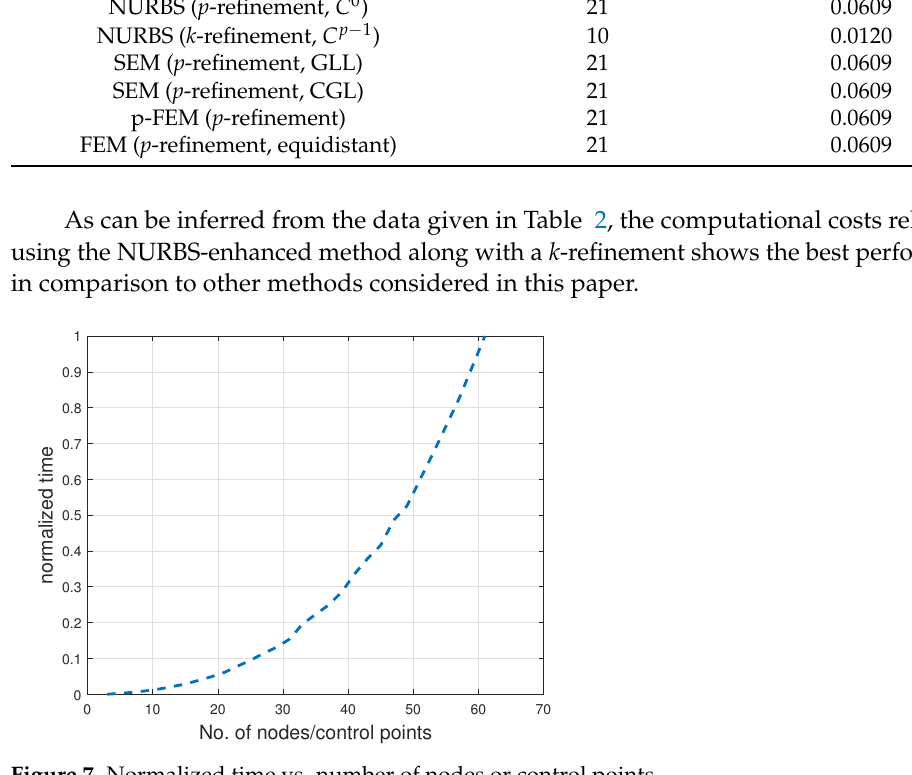
Figure 7. Normalized time vs. number of nodes or control